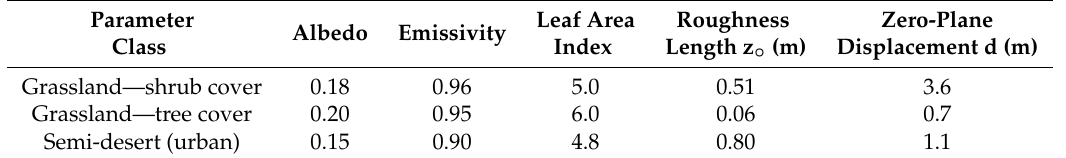
Table 2. Some parameters used in the advanced regional prediction system (ARPS) model for three different types of vegetation cover.